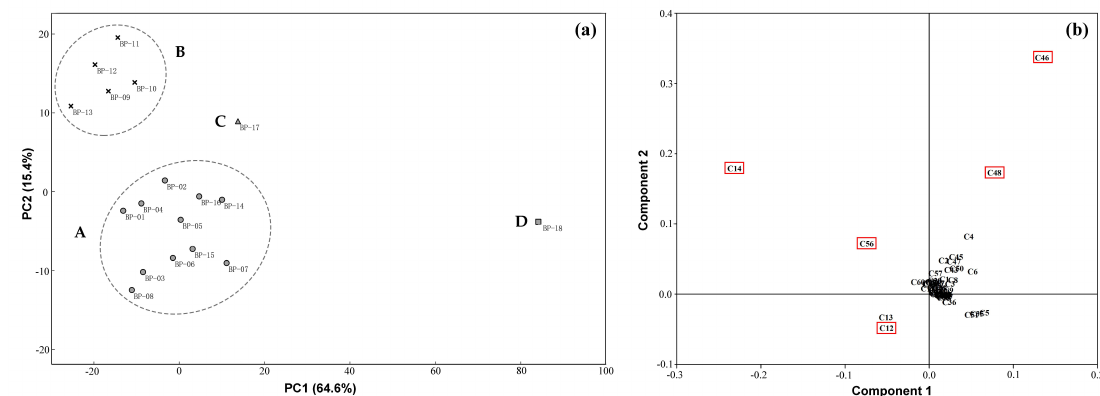
Figure 2. PCA score plot ( a ) and correlation plot ( b ) of 18 batches of Bolbostemma paniculatum based on all the characterized components.